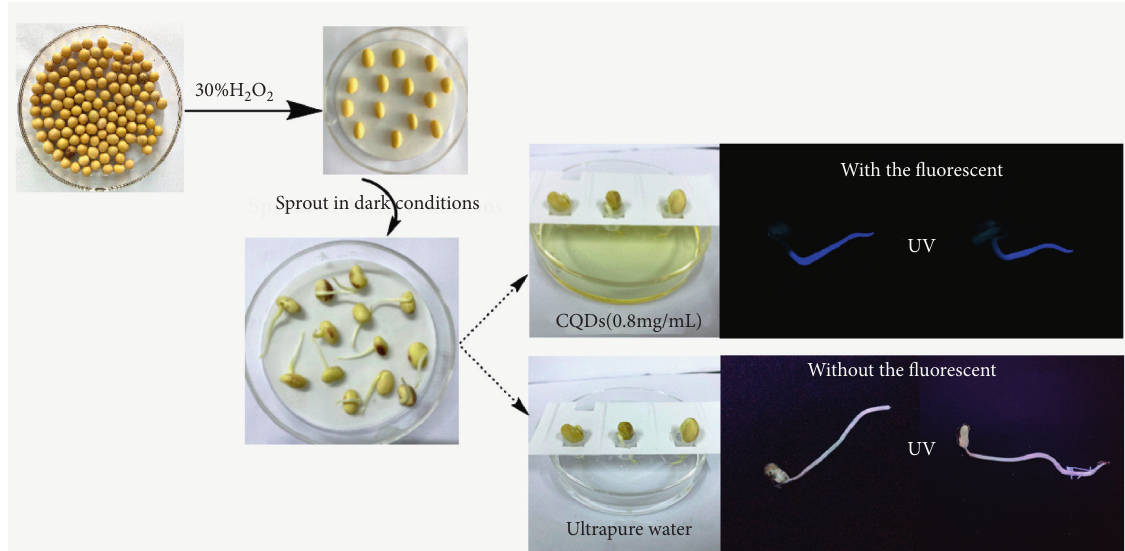
Figure 9: Soya bean sprout cultivation process and the images of the sprouts under UV (365